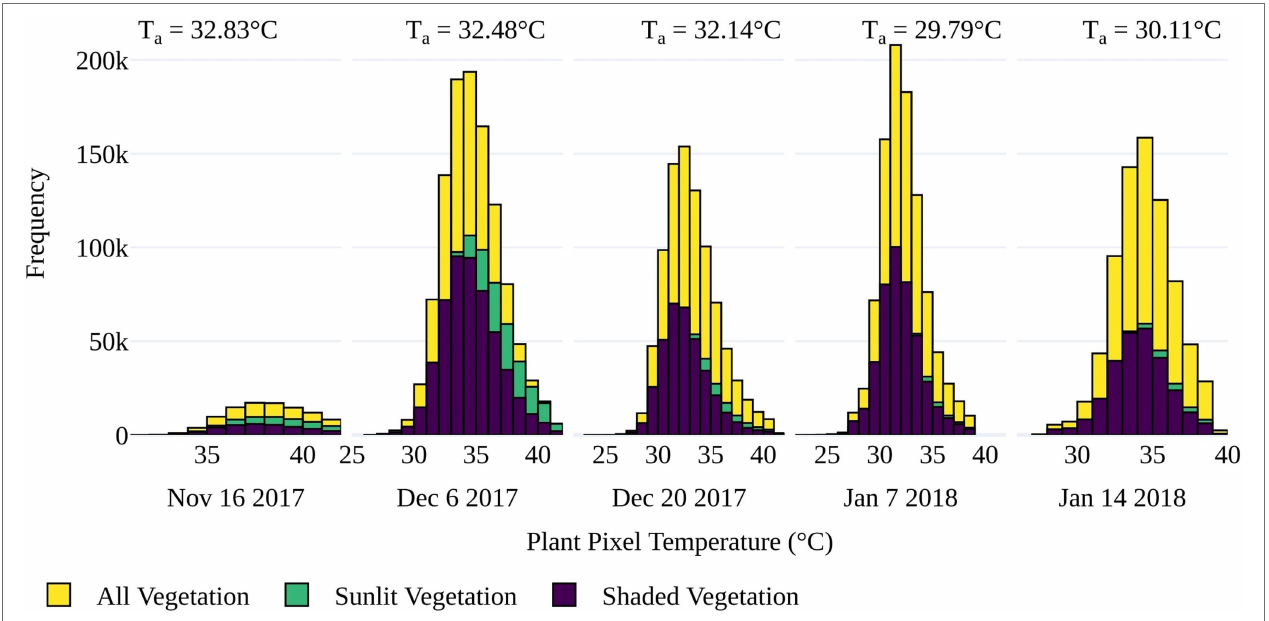
FIGURE 6 | Distribution of pixel temperatures for sunlit, shaded, and all vegetation as classified by GRVI > 0 for the five UAV data collection dates. Sunlit vegetation was identified as pixels with a reflectance value greater than the maximum value in the first cluster of a five-cluster k-mean approach based on the blue band. Average air temperature (T a ) during each flight is also displayed.